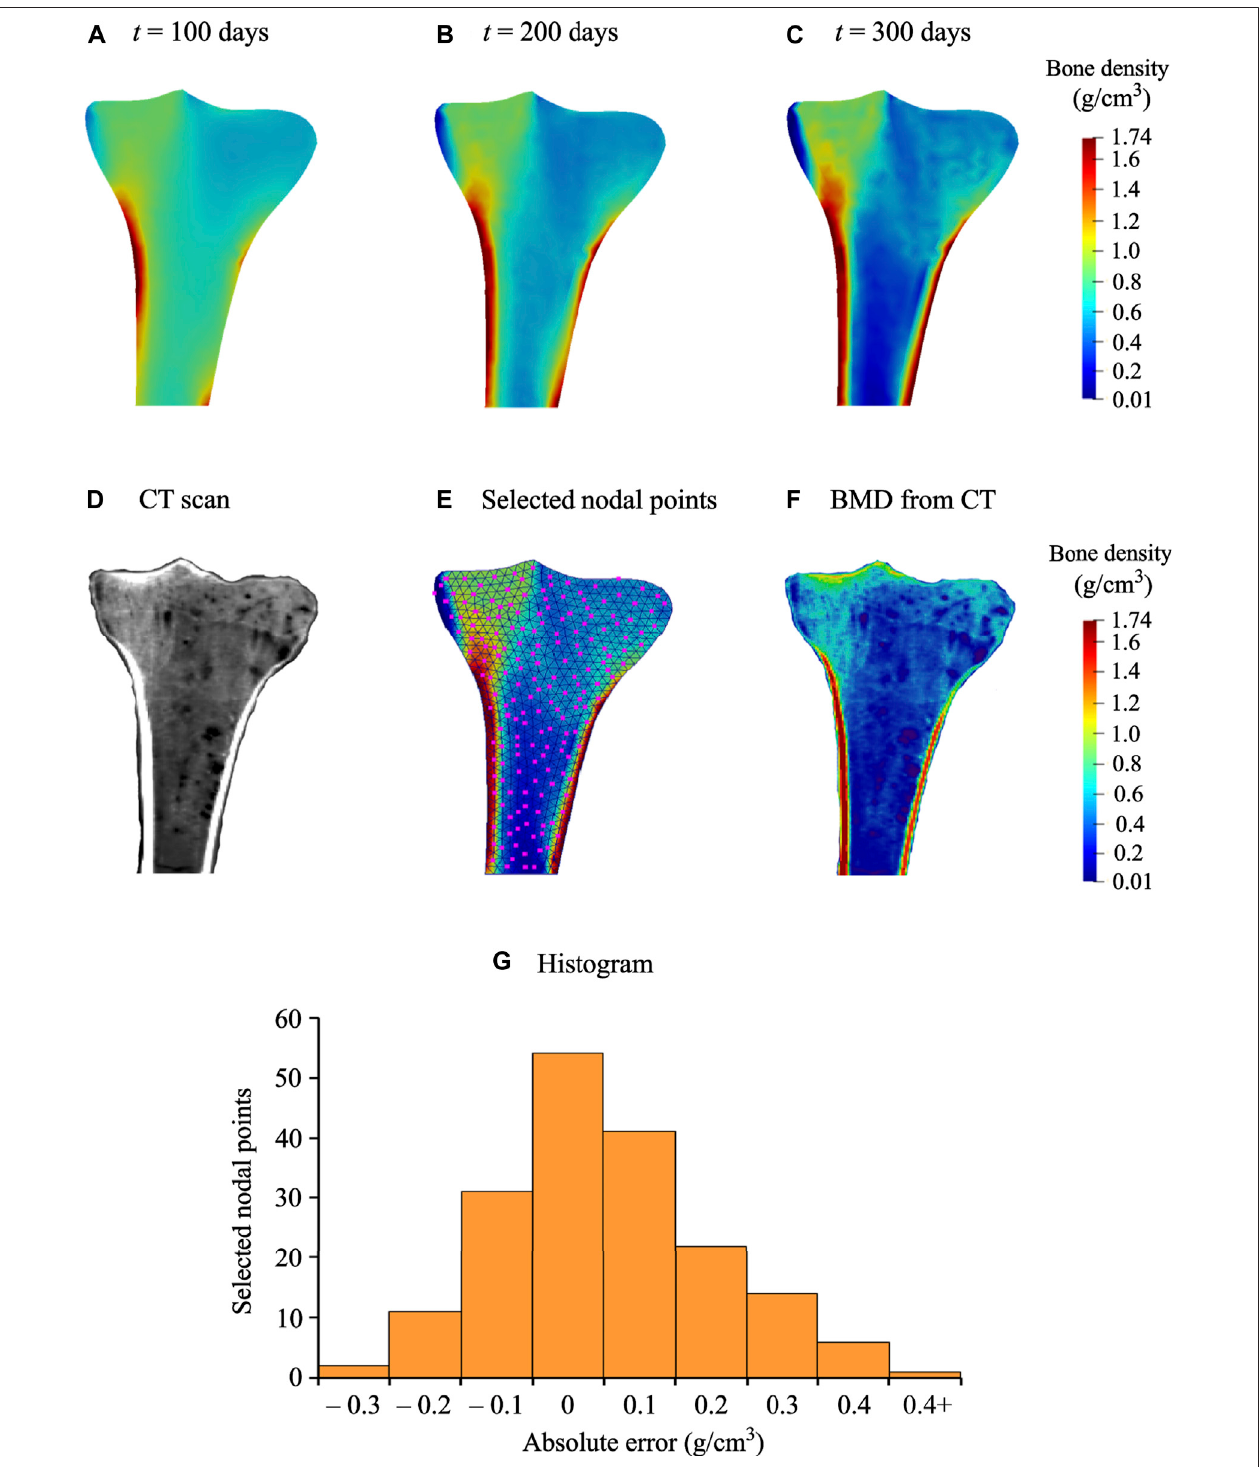
FIGURE5| Evolutionofbonedensityattime: (A) t (cid:1) 100 days, (B) t (cid:1) 200days,and (C) t (cid:1) 300 days. (D) Qualitativecomparisonofpredictedbonedensitywiththe CTscanoftheproximaltibia. (E) Locationofthemanuallyselected182nodalpointsforcomputingtheRMSerrorandMD. (F) Quantitativecomparisonofpredictedbone density with the BMD calculated from the CT (G) Histogram of absolute error (g/cm 3 ) for the selected nodal points.